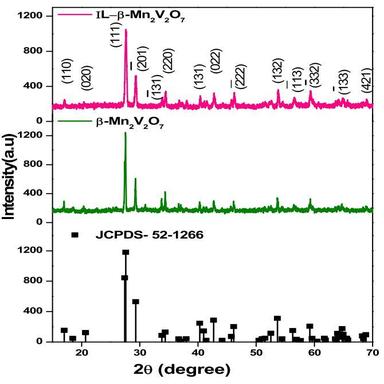
XRD patterns of JCPDS No: 52-1266, β-MNV and IL-β-MNV.